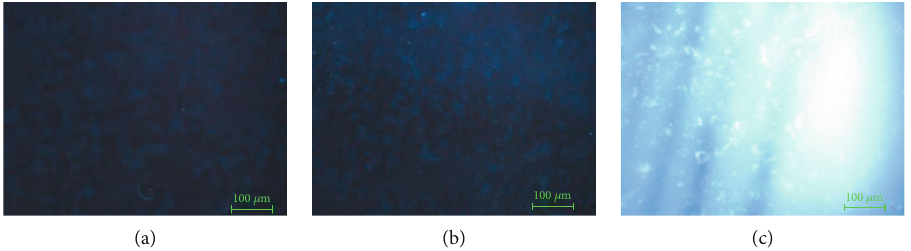
Figure 15: Calibration test of fl uorescence microscopic observation. (a) An empty microslide. (b) Microslide with water. (c) Microslide with